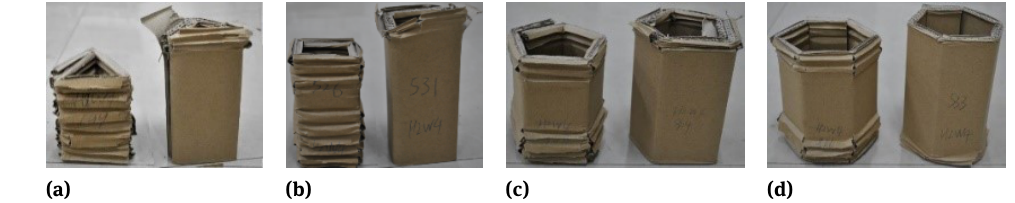
Figure 4: Deformation modes for different tube directions: (a) triangle, (b) quadrangle, (c) pentagon and (d) hexagon